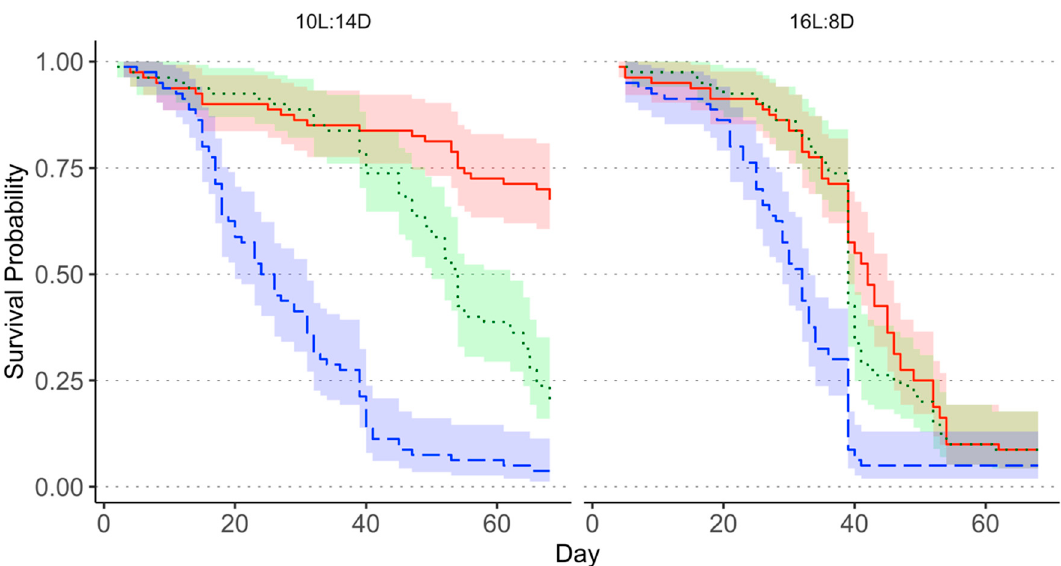
Figure 3. Survival curve for the September collection showing differences in the instantaneous survival probability between the acetone (red solid line), 1.0% pyriproxyfen (blue dashed line), and 0.1% pyriproxyfen (green dotted line), separated by photoperiod treatment. Shaded areas represent 95% confidence intervals.